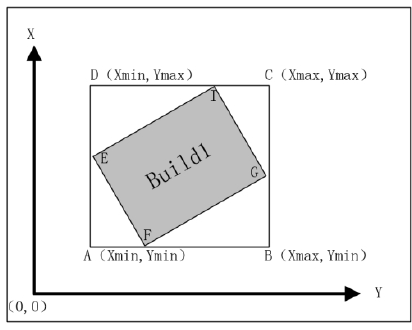
Figure 3. Schematic diagram of top data extraction from buildings